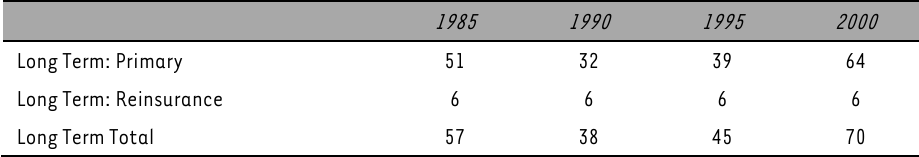
Number of Long-Term Insurance Companies, 1985-2000